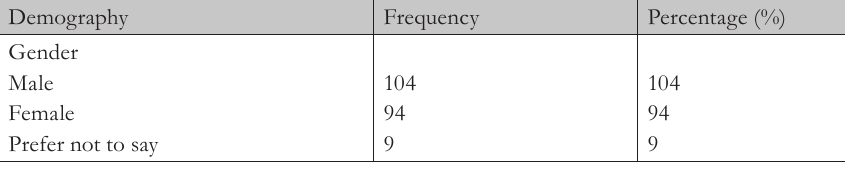
Tab. 1 - Demographic profile of respondents. Source: own